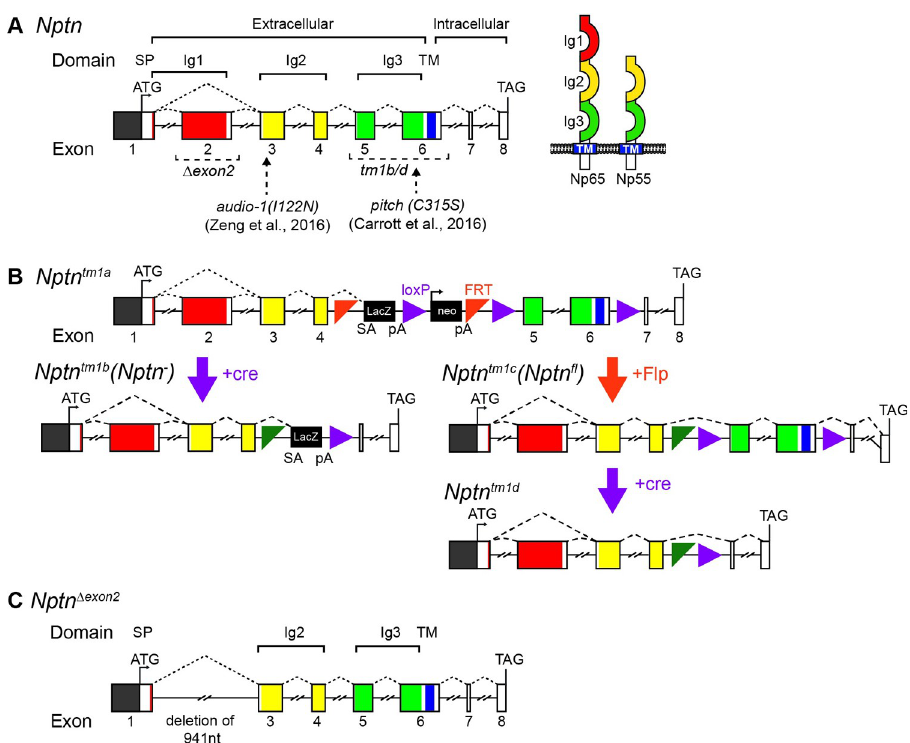
Fig 1. Neuroplastin gene schematic and alleles. (A) Schematic of the wild type Neuroplastin gene locus consisting of eight exons that encode: three extracellular Ig domains; a transmembrane region (TM); and, a short intracellular region. Alternative splicing involving the inclusion, or skipping, of exon 2 leads to the production of transcripts encoding the larger Np65, or smaller Np55, protein isoform, respectively. Previously reported mutant alleles audio-1 [13] and pitch [12] are point mutations present in exons 3 and 6, respectively, affecting both isoforms. (B) the Nptn tm1a (EUCOMM)Hmgu (Nptn tm1a ) is a knockout first, conditional-ready allele, that was used to generate both the Nptn tm1b (EUCOMM)Hmgu (Nptn tm1b ) knockout allele lacking exons 5 and 6, and the Nptn tm1c(EUCOMM)Hmgu (Nptn fl ) floxed allele. Subsequent exposure of the Nptn fl allele to cre recombinase excises exons 5 and 6, resulting in a null allele ( Nptn tm1d ) in cells expressing cre . (C) An isoform-specific Np65 knockout mutant ( Nptn Δ exon2 ) was generated using CRISPR/ Cas9-mediated deletion of 941 nucleotides encompassing exon 2. Mice homozygous for the Nptn Δ exon2 are unable to express the larger Np65 isoform, while expression of Np55